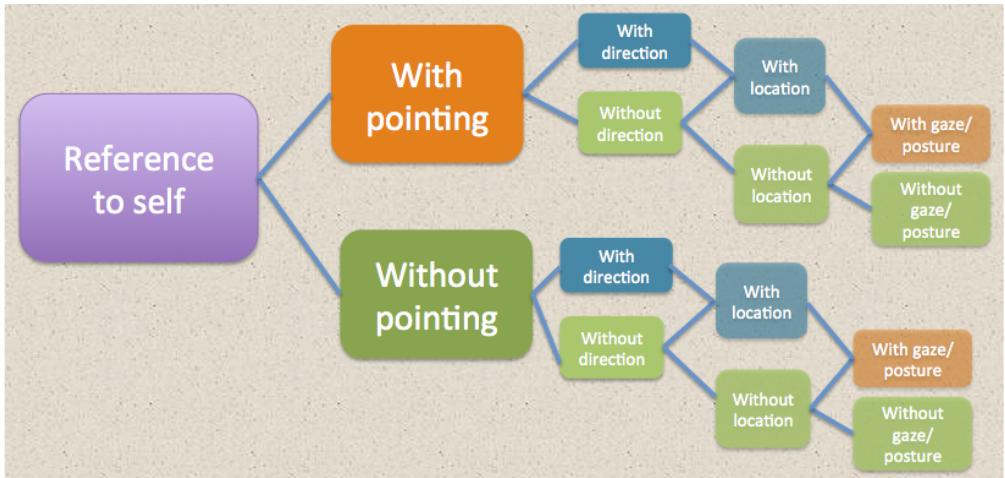
Figure 1: Reference to self in LSF (French Sign